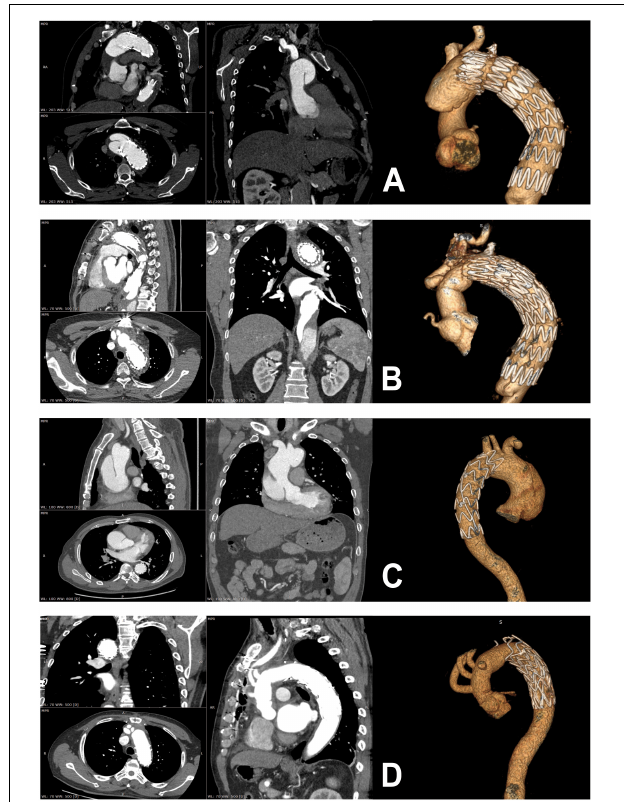
FIGURE 1 | Preoperative and postoperative computed tomographic scans of patients with retrograde type A dissection (A,B) and antegrade type A dissection (C,D)